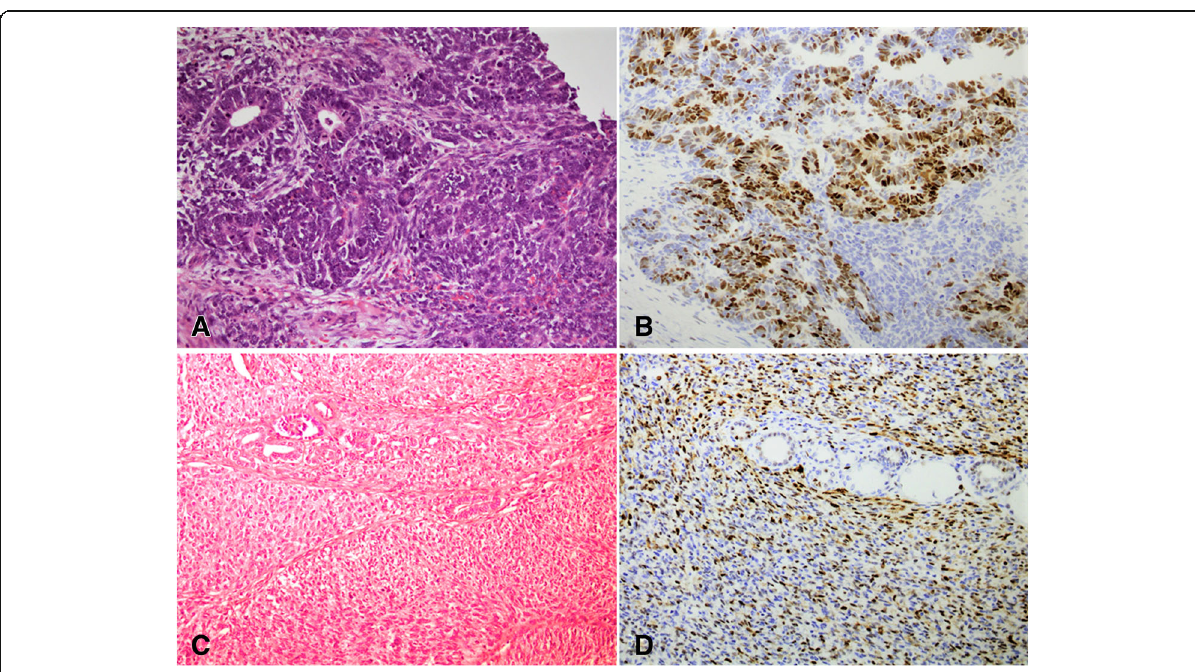
Fig. 2 Classic Wilms tumor of kidney with epithelial and blastemal component ( a ). Cyclin D1 is strongly positive in the tubules while blastemal component shows rare positivity ( b ). Cellular congenital mesoblastic nephroma exhibiting trapped renal tubules ( c ), showing moderate to marked staining for Cyclin D1 ( d